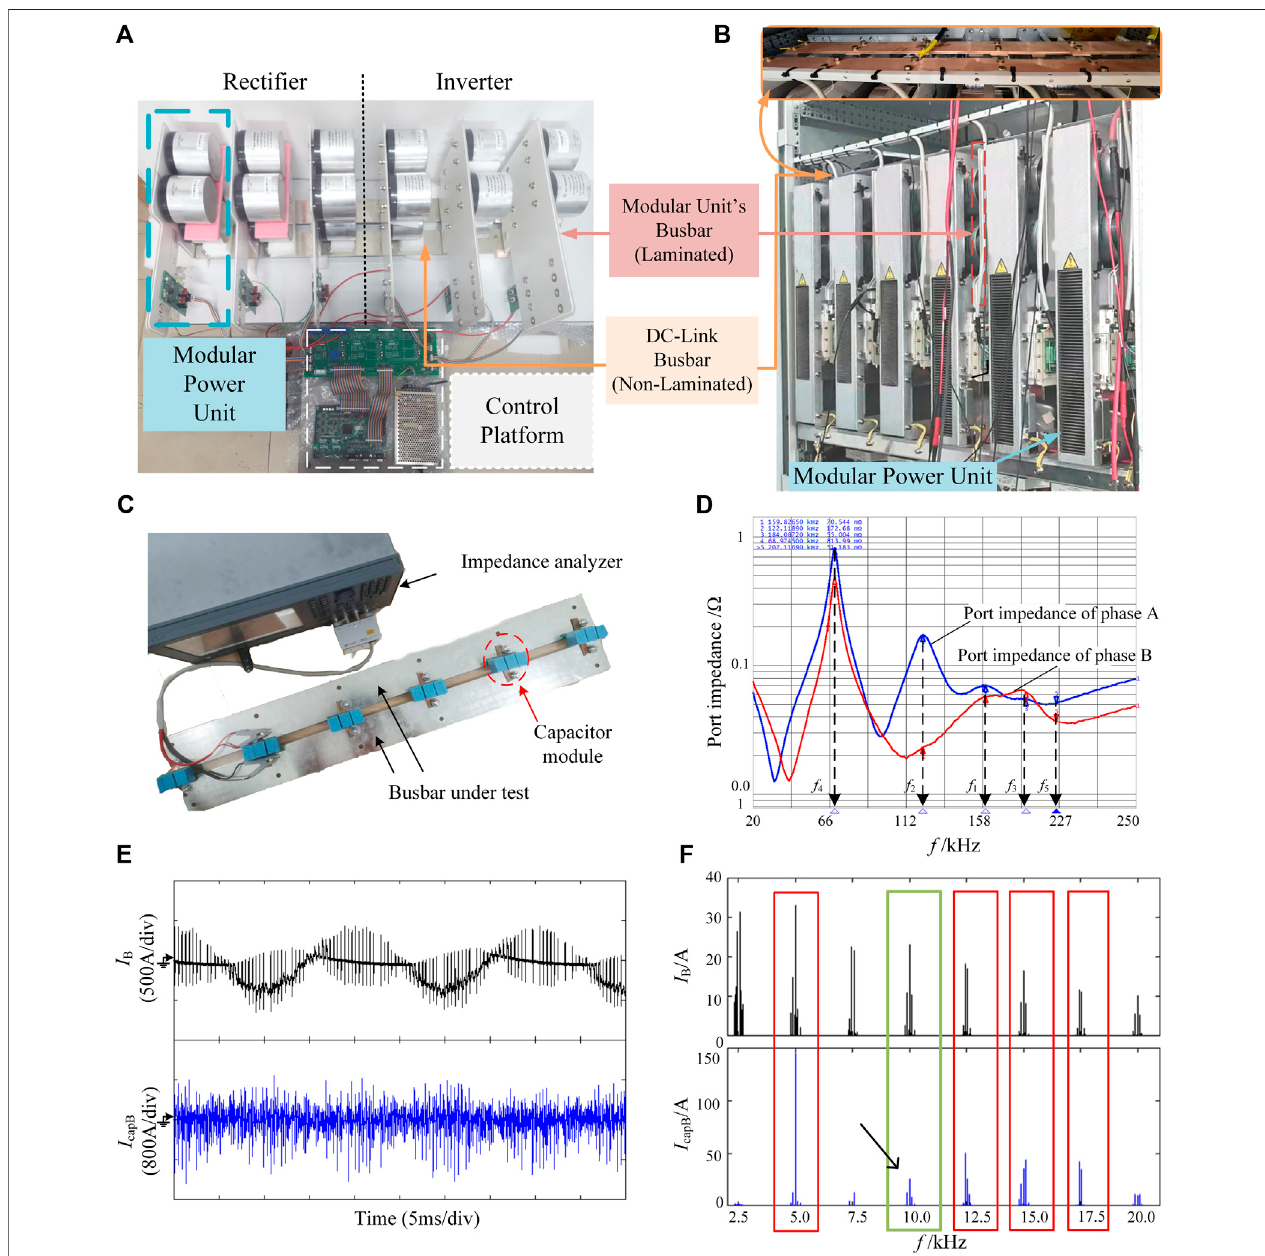
FIGURE8|(A) Busbarsofthe2 MWconverter (B) Completesetupof2 MWrealpowerconverter (C) Busbarimpedancenetworkplatformundertest (D) Experimental result of impedance network of prototype (E) Bridge and capacitor current experimental waveforms of the 2 MW converter in phase B (F) Corresponding FFT Using star-delta transformation, Figure 6A can be simpli fi ed to Figure 6B , where impedance Z 12 = Z 23 . The ports 1-2-3 can be equivalent to the impedance Z 1 using circuit symmetry, as shown in Figure 6B . The equivalent circuits Figures 6D,E are obtained by exploiting the circuit symmetry and repeating star transformation. It can be seen from the fi nal equivalent circuit Figure 6E , the impedance Z PL between port PL is twice the impedance Z PN between the ports PN. Since the impedance expressions of the PN and PL ports only differ by constant coef fi cients; hence, there is no